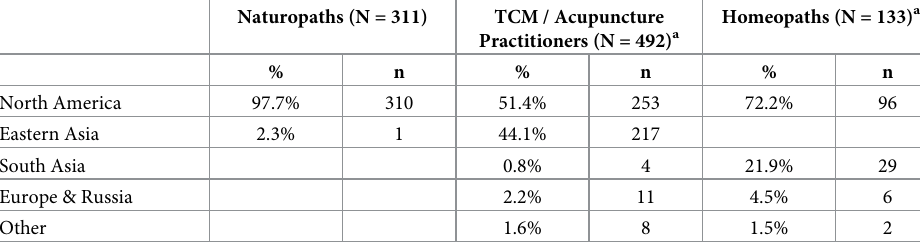
Table 3. Breakdown of primary training sites by continental